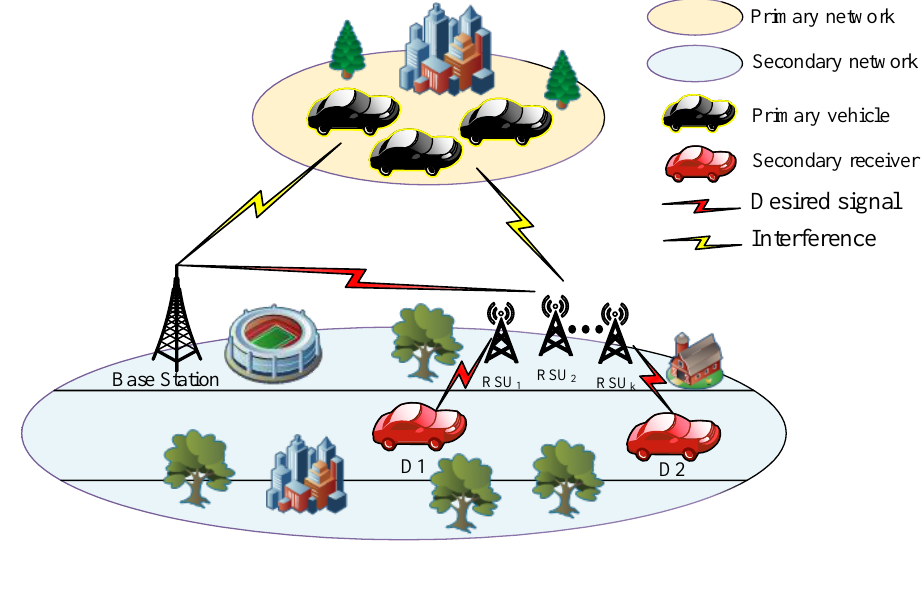
Figure 1. The model of the V2X-NOMA